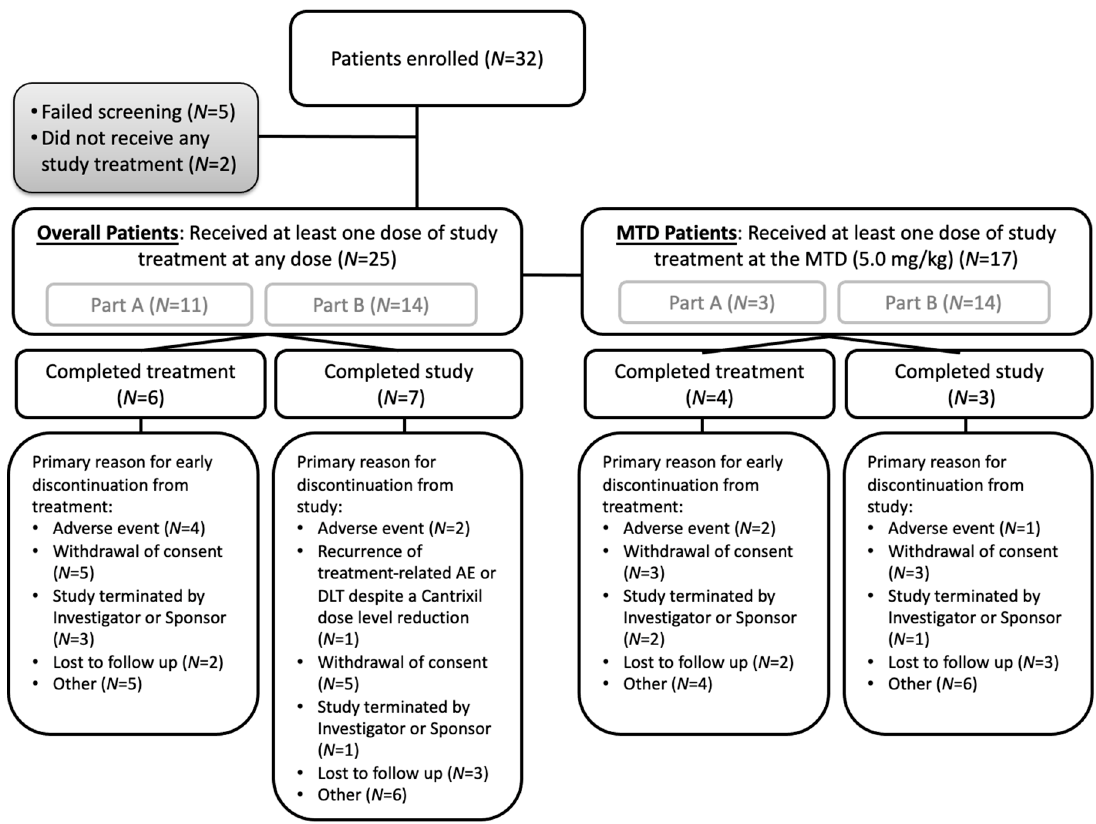
Figure 2. Patient disposition, with separate details of the overall patient population and the patients included in the MTD population. AE: adverse event; DLT: dose-limiting toxicity; MTD: maximum tolerated dose. Patients were defined as enrolled when signing informed consent. Figure includes patients from Parts A and B receiving at least 1 dose of Cantrixil (Overall Patients) and at least one dose of Cantrixil at the MTD of 5.0 mg/kg (MTD Patients).